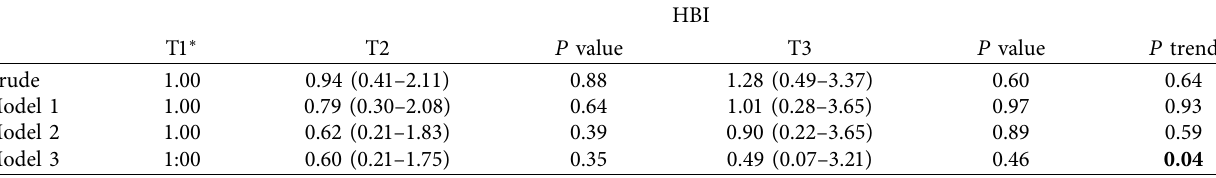
Table 4: Odds ratio and 95% confdence interval for the association between tertiles of healthy beverage index and metabolic